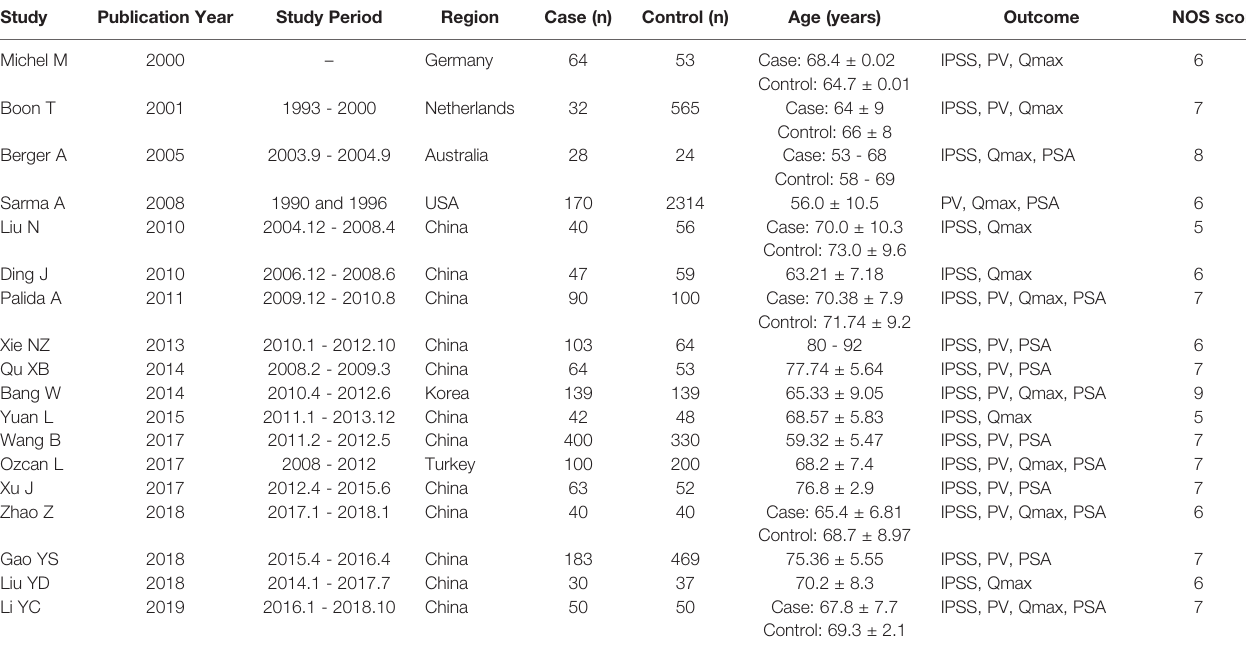
TABLE 1 | The characteristic of the selected studies in the meta-analysis.